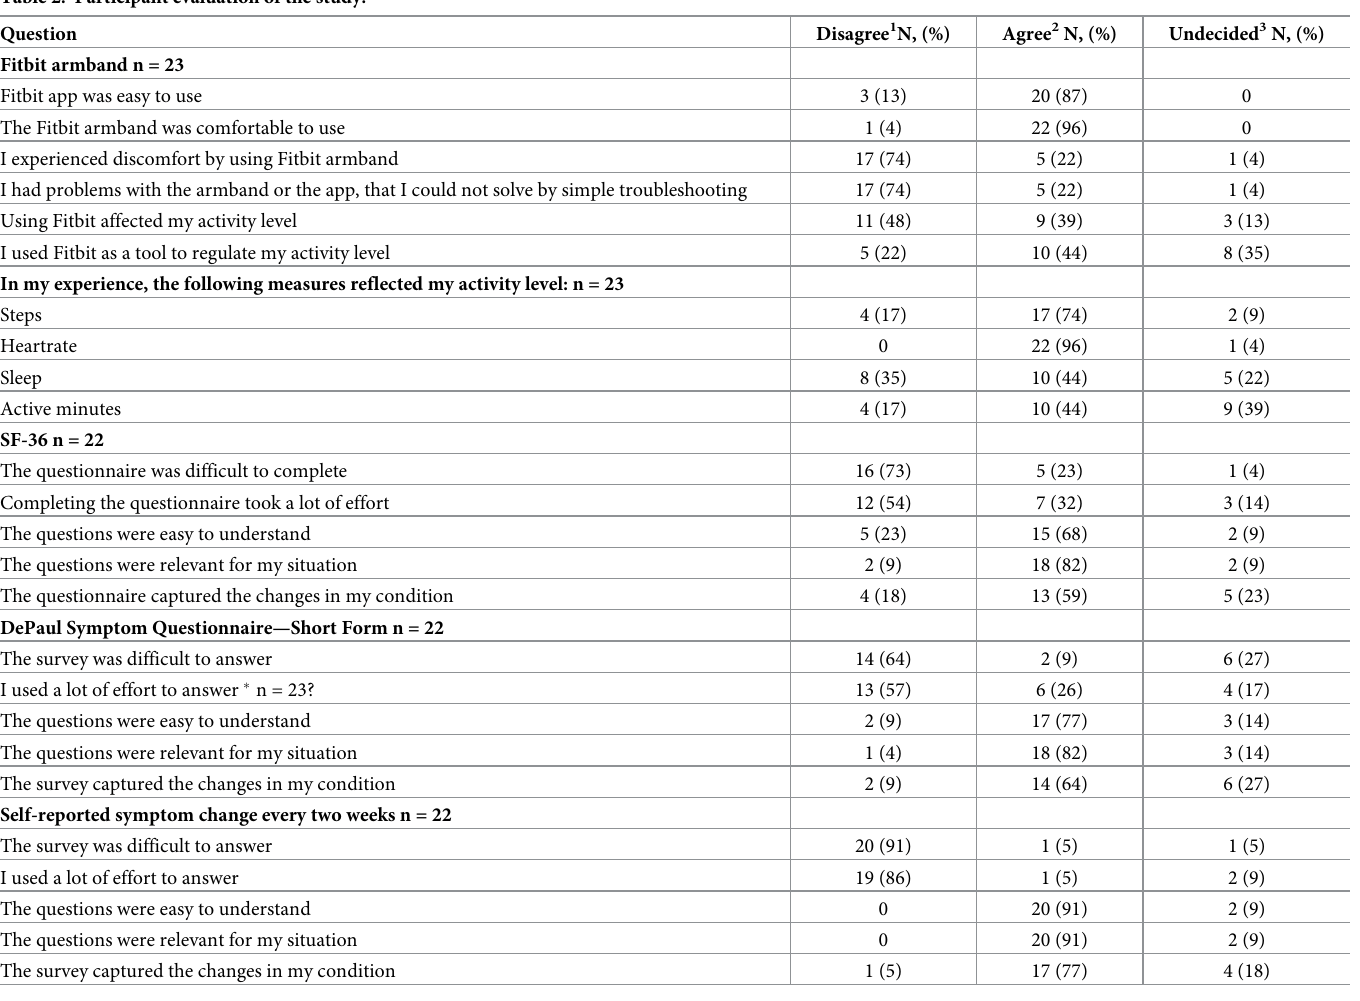
Table 2. Participant evaluation of the